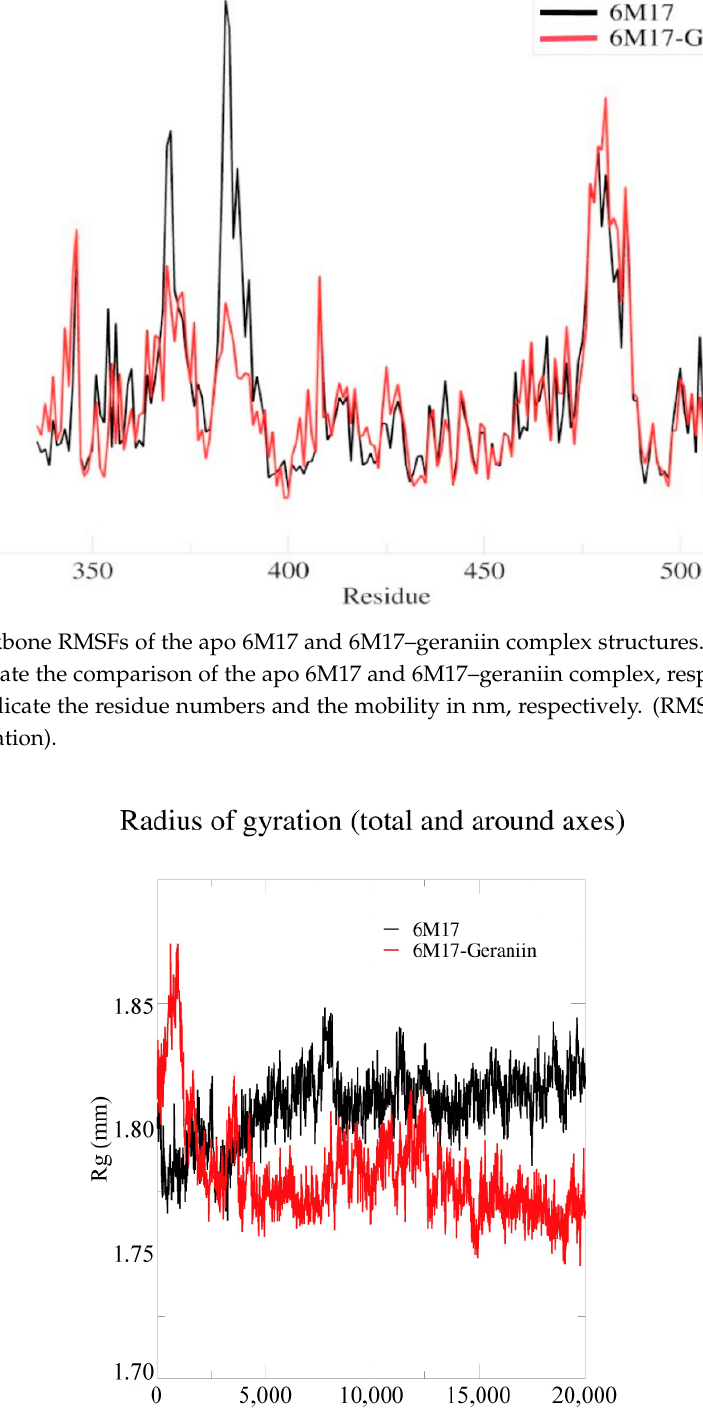
Figure 6. Radius of gyration (Rg) of backbone atoms of the apo 6M17 and 6M17–geraniin complex proteins. The ordinate is Rg (Å (nm)), and the abscissa is time (ns). The black and red lines indicate the apo 6M17 and 6M17–geraniin complex, respectively.